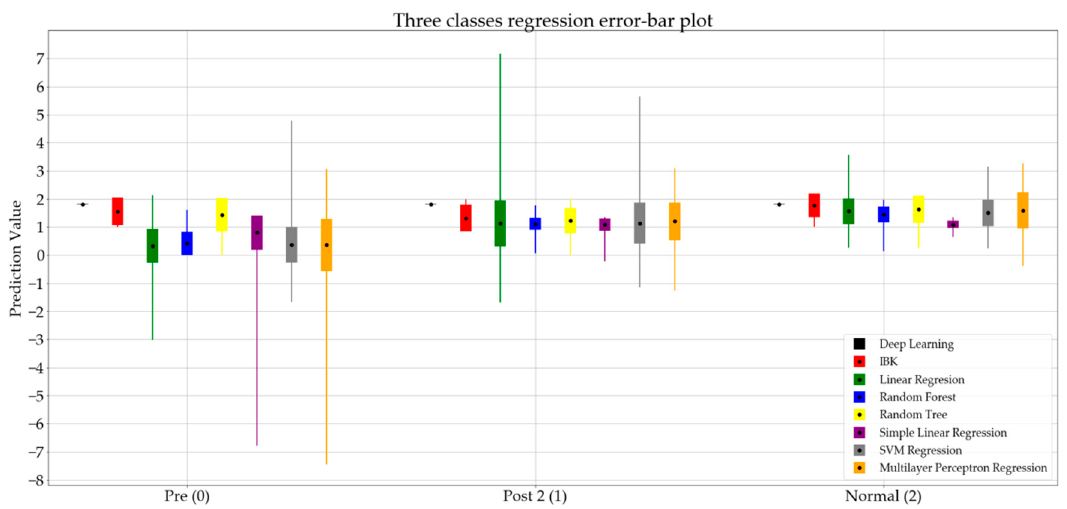
Figure 5. Error bar plot for eight regression algorithms classifying data into three Figure 5 . Error bar plot for eight regression algorithms classifying data into three classes.